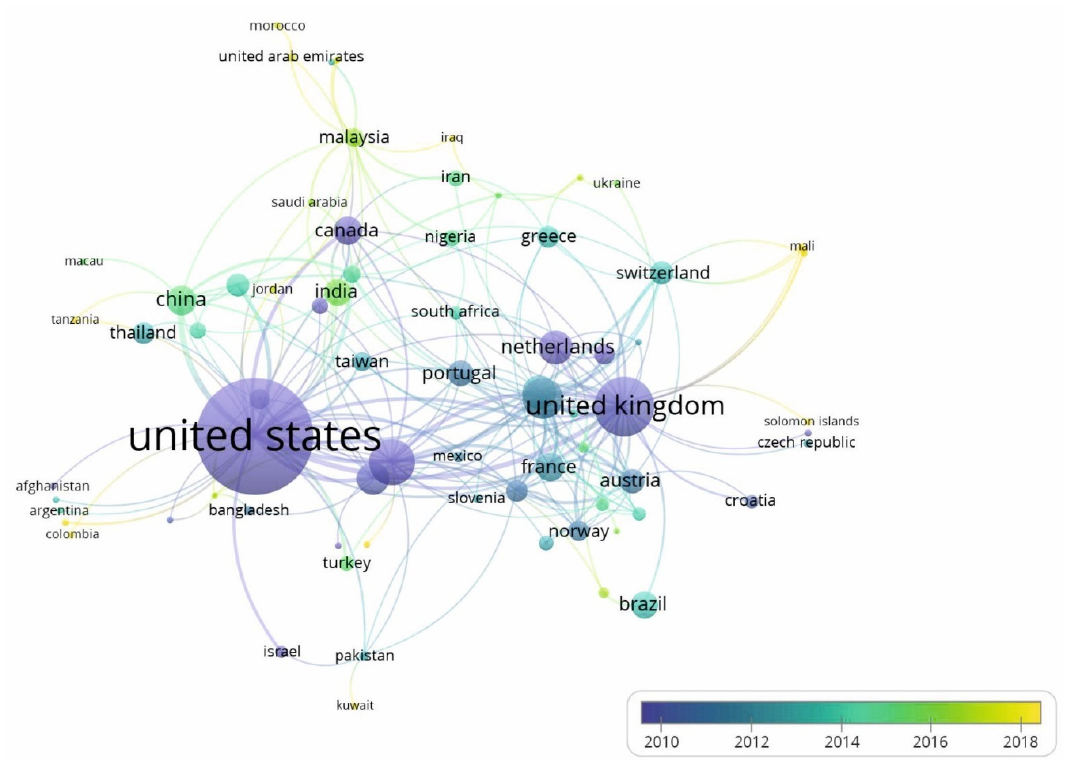
Figure 7. Evolution of cooperation between countries based on co-authorship.